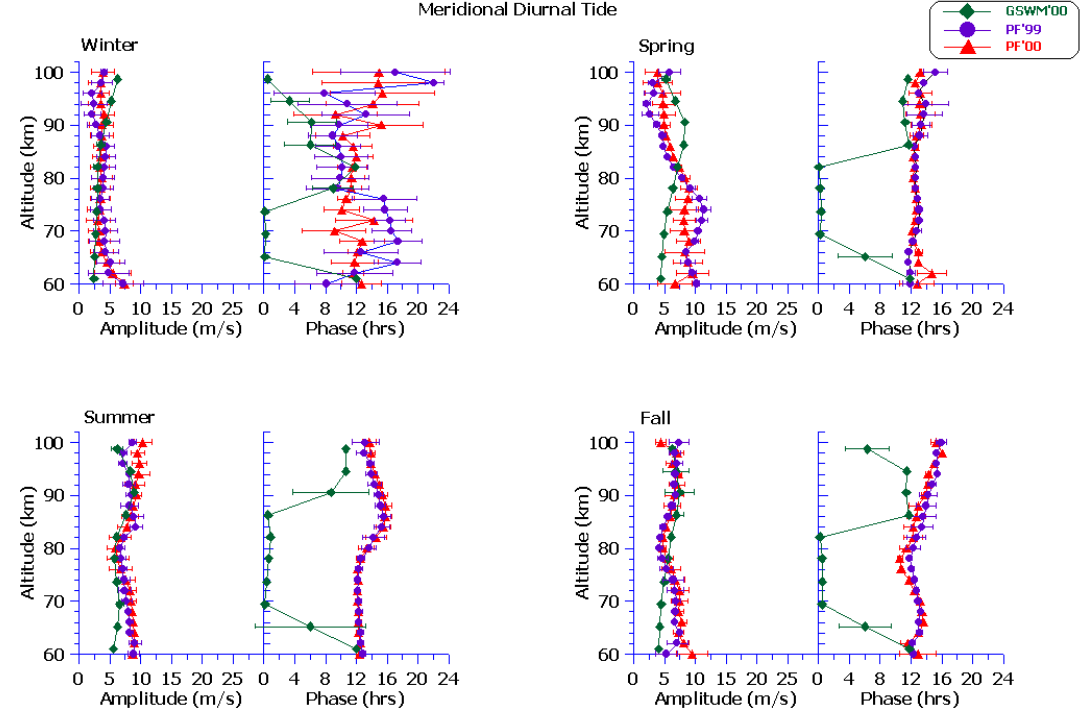
Fig. 12. As in Fig. 11 but for the meridional